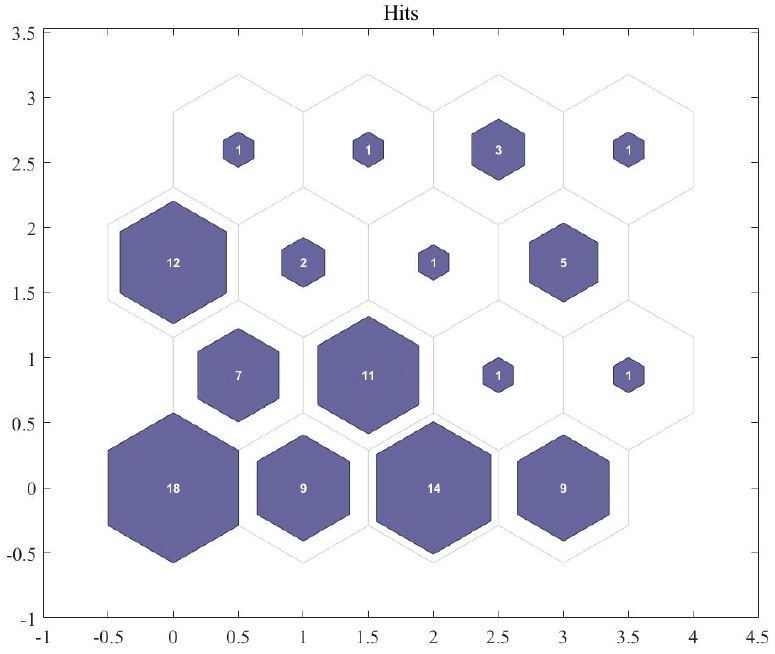
Figure 6. Result of SOM